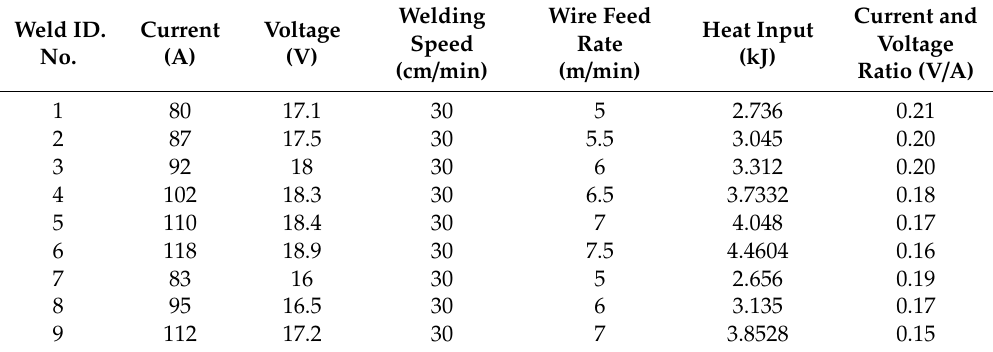
Table 1. Parameters of single-layer and multi-layer deposition.